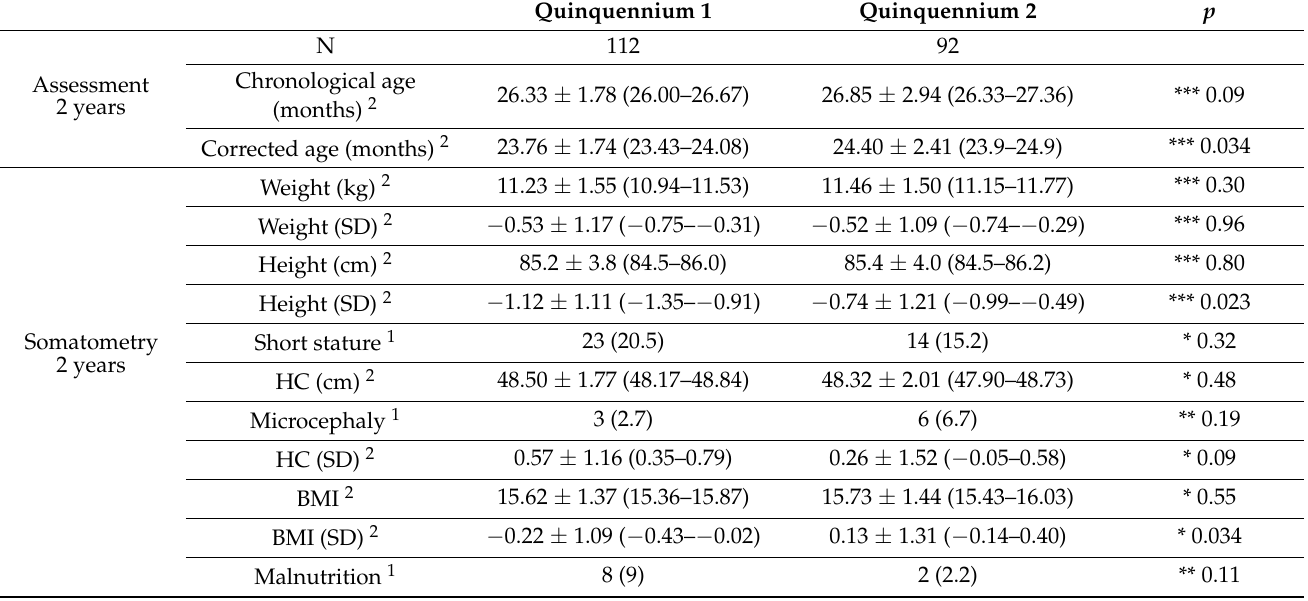
Table 4. Change in neonatal somatometry (quinquennium 1: 2002–2006 vs. quinquennium 2: 2013–2017).